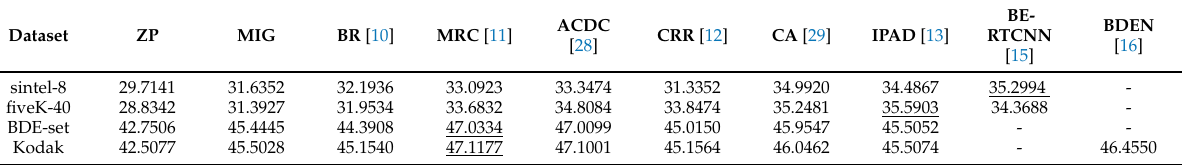
Table 1. Comparison with state-of-the-art on PSNR.